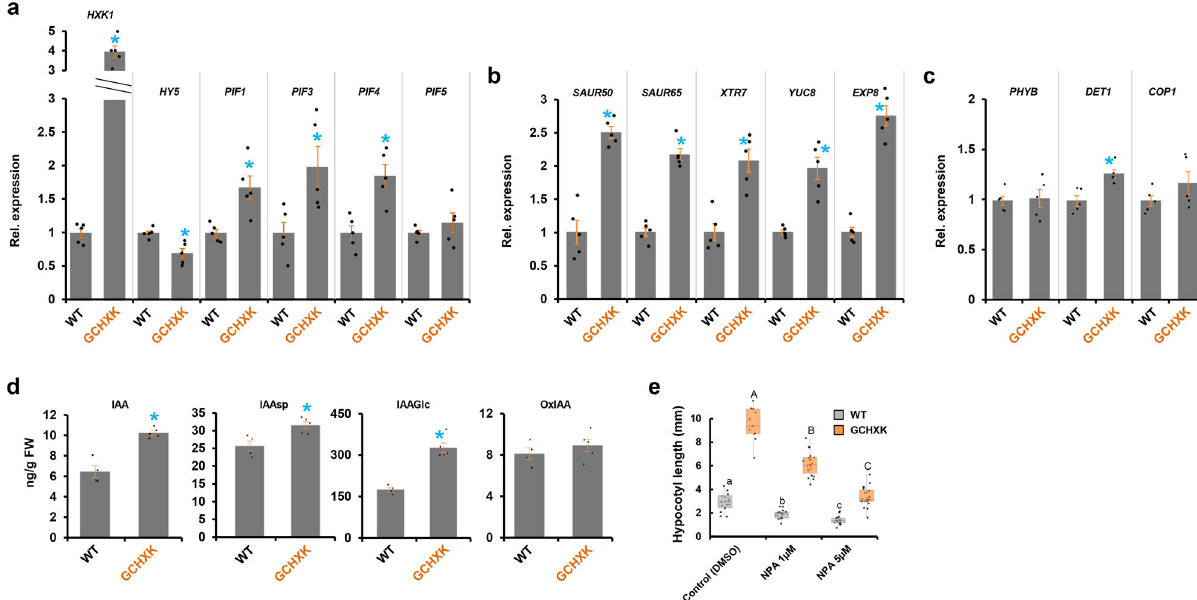
Fig. 3 Relative expression of genes related to hypocotyl elongation, auxin levels, and auxin transport activity in GCHXK seedlings. a – c RT-PCR expression analysis of genes related to the hypocotyl elongation of WT and GCHXK seedlings grown in 0.5 MS agar media. TUB2 ( β -tubulin) was used for normalization and the expression level in the WT was set to one. Data points are mean ± SE ( n = 5). d GCHXK promotes the accumulation of auxin. IAA, IAAsp, IAGlu, and OxIAA quanti fi cation in 5-day-old WT and GCHXK seedlings. Data points for are means ± SE ( n = 4 and 5 for WT and GCHXK, respectively). a – d Black dots represent individual data points, and blue asterisks indicate a signi fi cant difference relative to the WT ( t test, P < 0.05). e Auxin transport activity is required for hypocotyl growth of GCHXK. WT and GCHXK seedlings grown in 0.5× MS agar media containing 1 or 5 µ M of NPA for 9 days. The box plots extend from the fi rst to third quartiles and the whiskers extend from the minimum to the maximum levels. Lines within the boxes signify median values and light gray dots represent individual data points ( n = 12 – 25). Different lower-case and capital letters indicate signi fi cant differences (Tukey ’ s HSD test, P < 0.05).